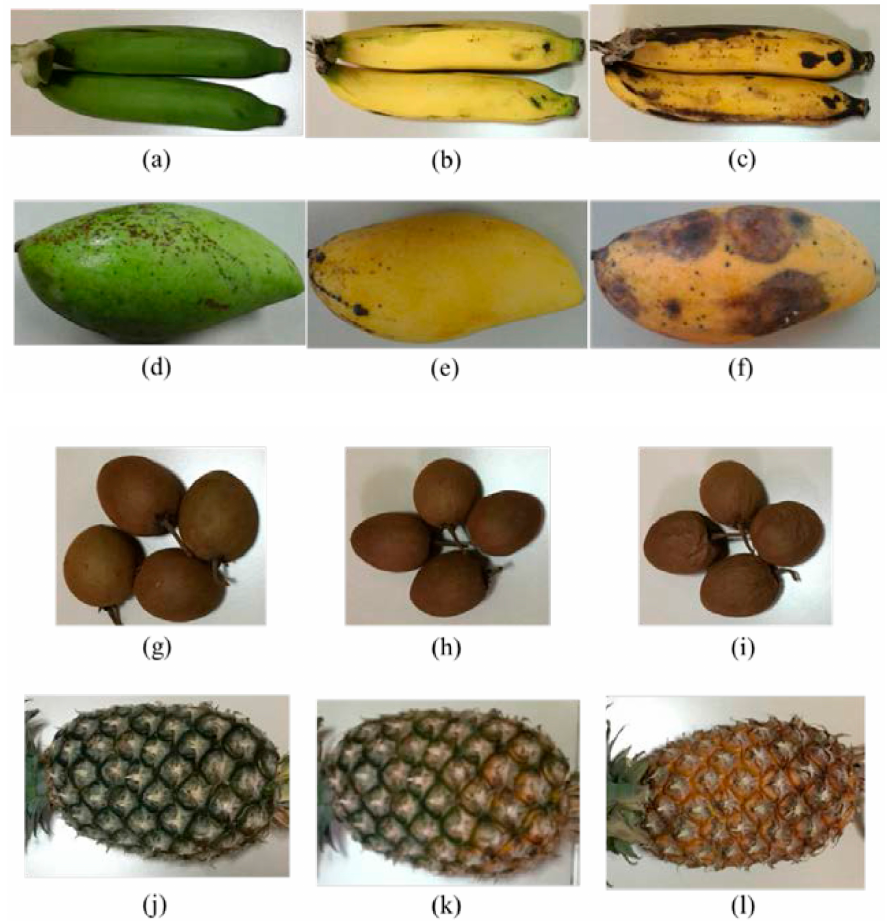
Figure 2. Fruit samples at different ripeness states: ( a ) unripe banana; ( b ) ripe banana; ( c ) rotten banana; ( d ) unripe mango; ( e ) ripe mango; ( f ) rotten mango; ( g ) unripe sapodilla; ( h ) ripe sapodilla; ( i ) rotten sapodilla; ( j ) unripe pineapple; ( k ) ripe pineapple; and ( l ) rotten pineapple.